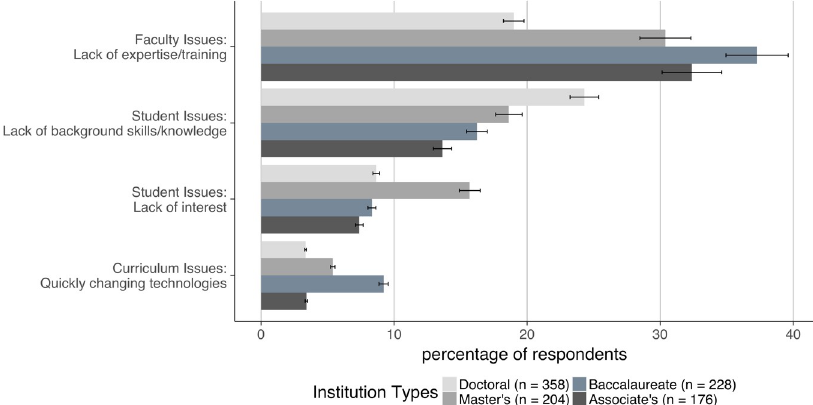
Fig 4. The biggest barrier at most institution types is lack of expertise/training. The figure shows four barriers that faculty at the different institution types experience the most differently. The margin of error, as the interval estimate of population proportion, was calculated at the 95% confidence level and is represented as error bars. Of the four, the lack of training/expertise was by far the most common problem at all institution types except for doctoral-granting institutions, where students’ lack of background skills/knowledge was the most common. Also of note is that students at master’s institutions seem less interested in bioinformatics than those at other institution types. See the Discussion for our thoughts on these two